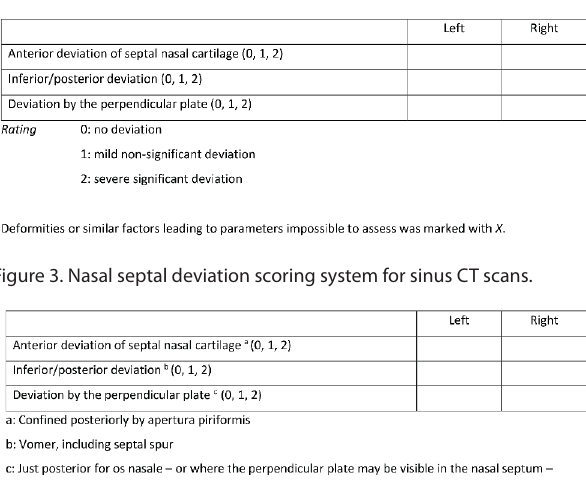
Figure 2. Nasal septal deviation scoring system for nasal endoscopy.